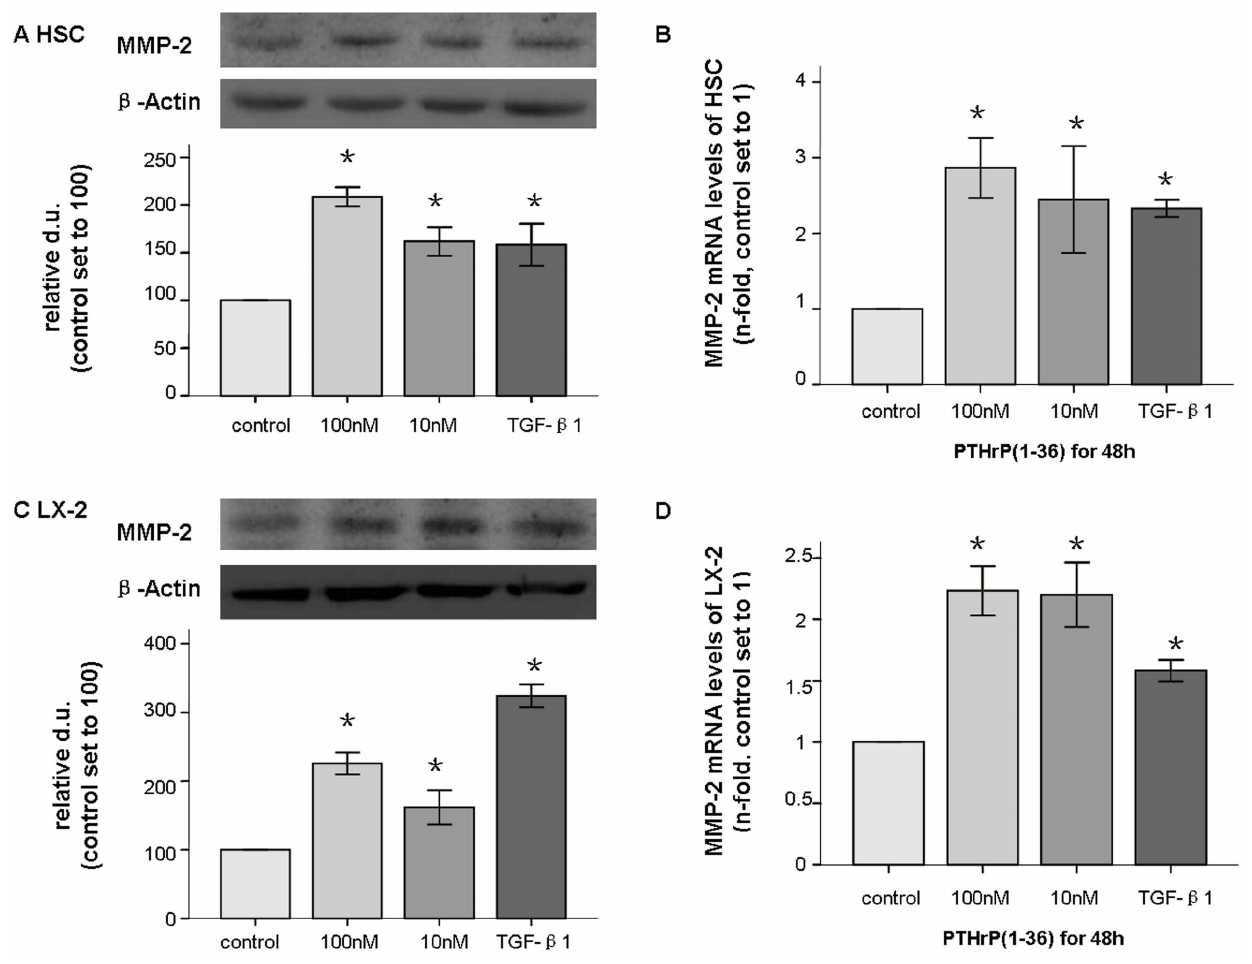
Figure 5. Increased production of MMP-2 in HSCs and LX-2 cells after PTHrP(1–36) treatment. After a 48 h treatment with 100 nM of PTHrP(1–36), the MMP-2 (72 kd) total protein levels were assessed by western blot (A); mRNA expression was measured with q-PCR and found to be increased in HSC (B). Similar patterns were observed for LX-2 cells (C and D). * p , 0.05 compared to the control group.